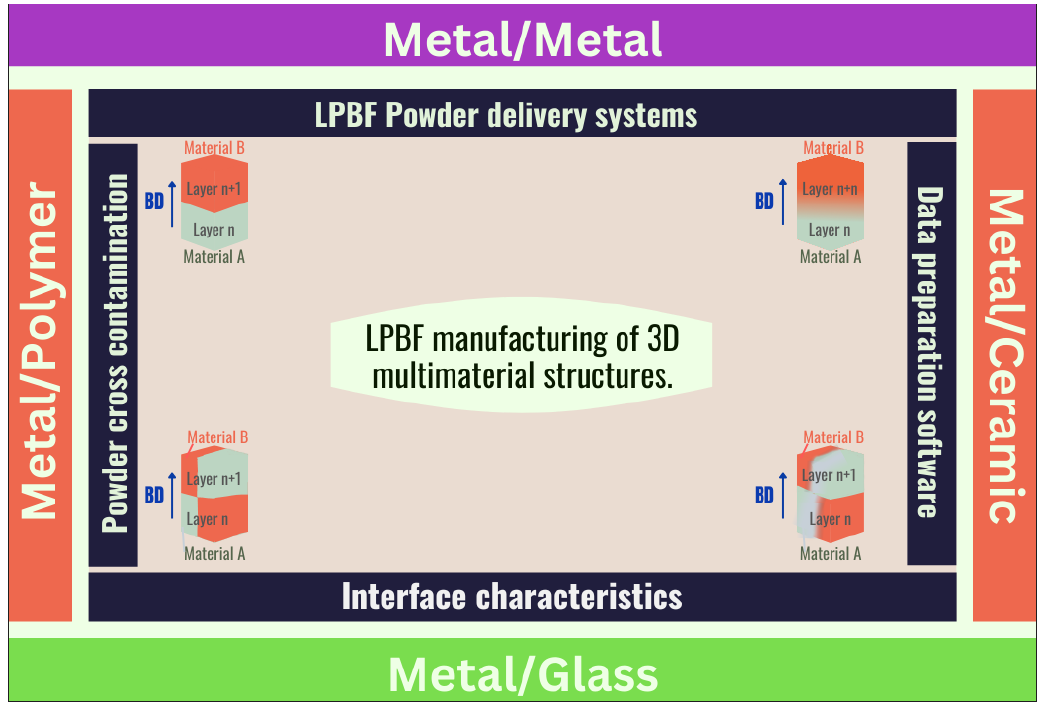
Figure 2. Challenges of distribution of multimaterial via LPBF.